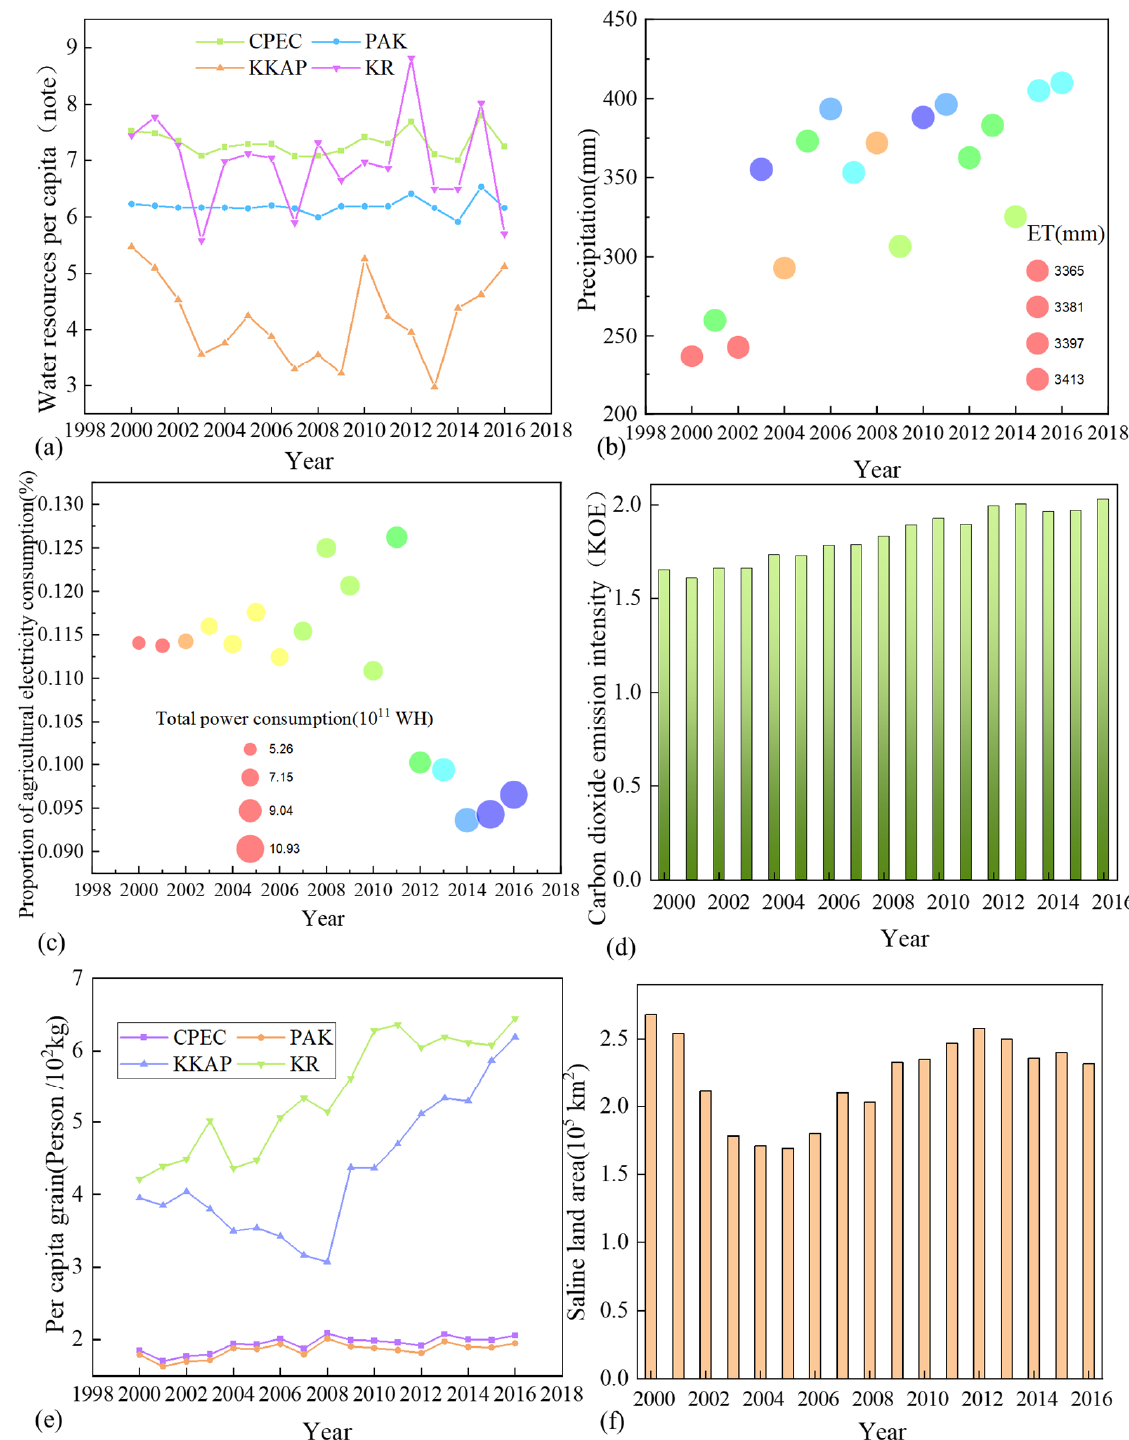
Figure 5. ( a ) Water resources per capita in the period 2000–2016. Note: The unit in KKAP is Person/10 4 m 3 . The unit in KR, the CPEC, and Pakistan is Person/10 3 m 3 . ( b ) Effective precipitation and evapotranspiration in the period 2000–2016. Among them, the size of the circle represents the annual change of ET, and the trend of the circle represents the trend of precipitation. ( c ) Energy consumption in the period 2000–2016. Among them, the size of the circle represents the total power consumption, and the trend of the circle represents the trend of the proportion of agricultural electricity consumption. ( d ) Carbon dioxide emission intensity in the period 2000–2016. ( e ) Per capita grain in the period 2000–2016. ( f ) Saline–alkali land area in the period 2000–2016.